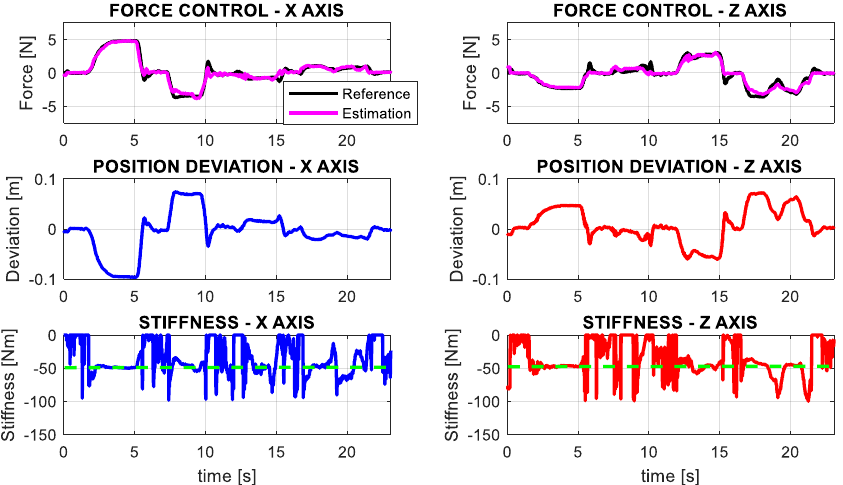
Figure 11. Force reference and estimation (up), position deviation (middle), and instantaneous sti ff ness (down) in the x - and z -axes for a desired sti ff ness K d = 50 [ Nm ] .